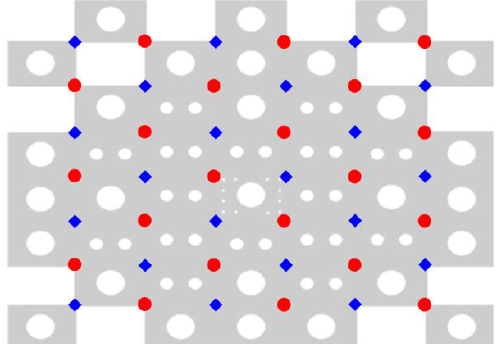
Figure 2. Test-bed design (diamond shape: points which are not given changing in height / circle shape : points which are given changing in height)